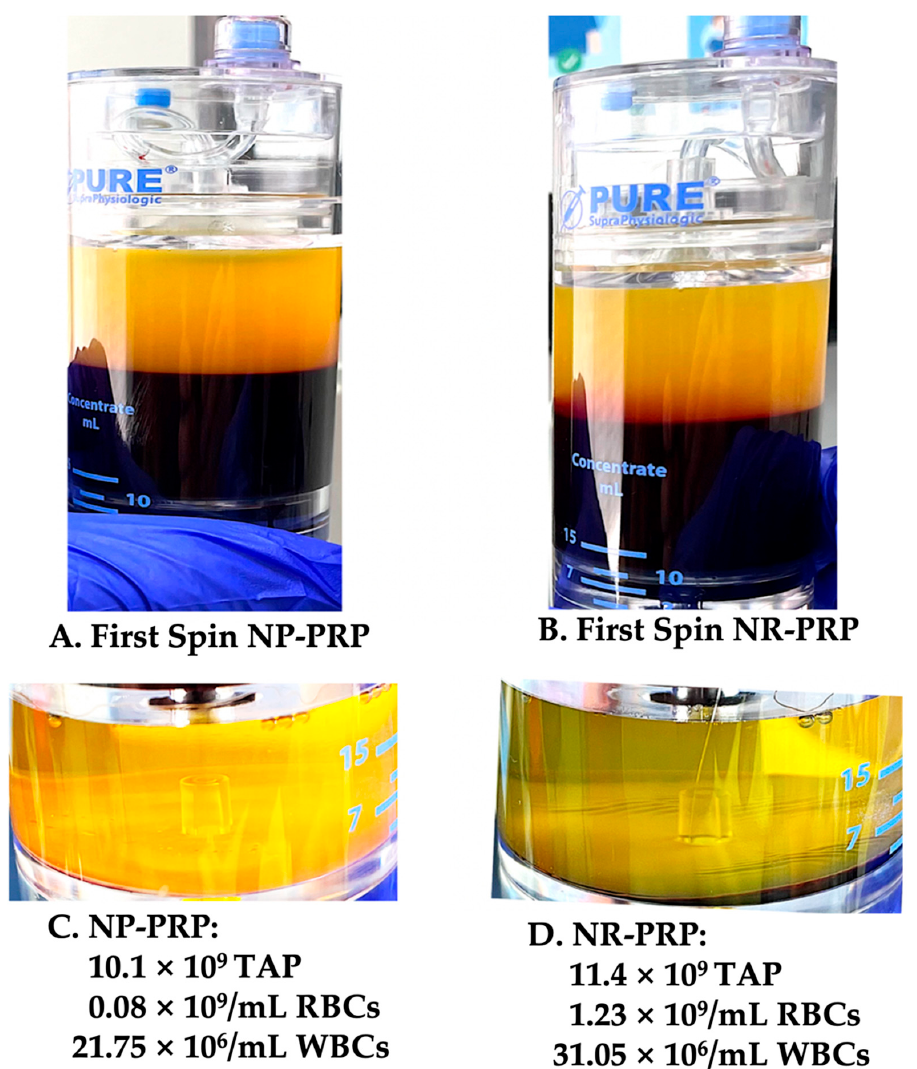
Figure 3. Visual aspects after the First and Second spin of NP-PRP and NR-PRP Preparations. After the first centrifugation spin, no differences occur for NP-PRP ( A ) and NR-PRP first phase preparation ( B ). During this cycle, the unit of whole blood is sequestered in a platelet poor plasma (PPP) fraction, thin buffy coat layer, and a packed RBC layer. After the second spin, the plasma in the second device chamber is removed until the remaining volume in each device is in accordance with the total calculated treatment volumes for both bioformulations. Thereafter, the cells at the bottom of the chamber are resuspended with the remaining plasma. Laboratory data present the differences between the NP-PRP ( C ) and NR-PRP ( D ) fractions. Note, the broader RBC layer in the NR-PRP vial ( D ) when compared to the NP-PRP preparation ( C ). Furthermore, the NR-PRP buffy coat stratum on top of the RBCs is more noticeable. (PurePRP-SP ® device, used with permission from EmCyte Corporation, Fort Myers FL, USA). (Abbreviation: TAP: total available platelets).